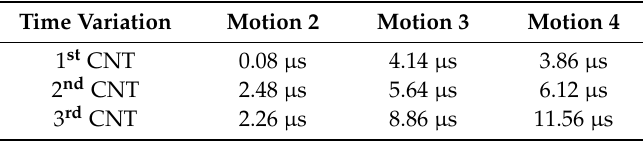
Figure 8. ( a ) Enveloped data according to the finger bending motion; ( b ) Corresponding times of the peak positions in (a); ( c ) visualization graph of the finger motion structure. Table 1. Time variations from Motion 1.